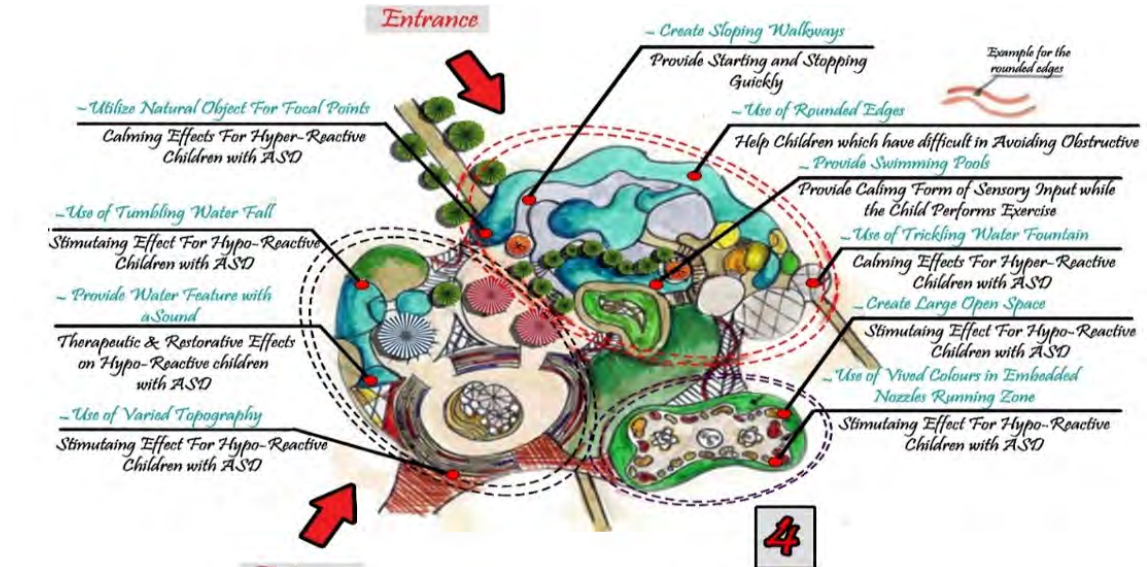
Figure 19. Shows the design consideration for the “water world” zone